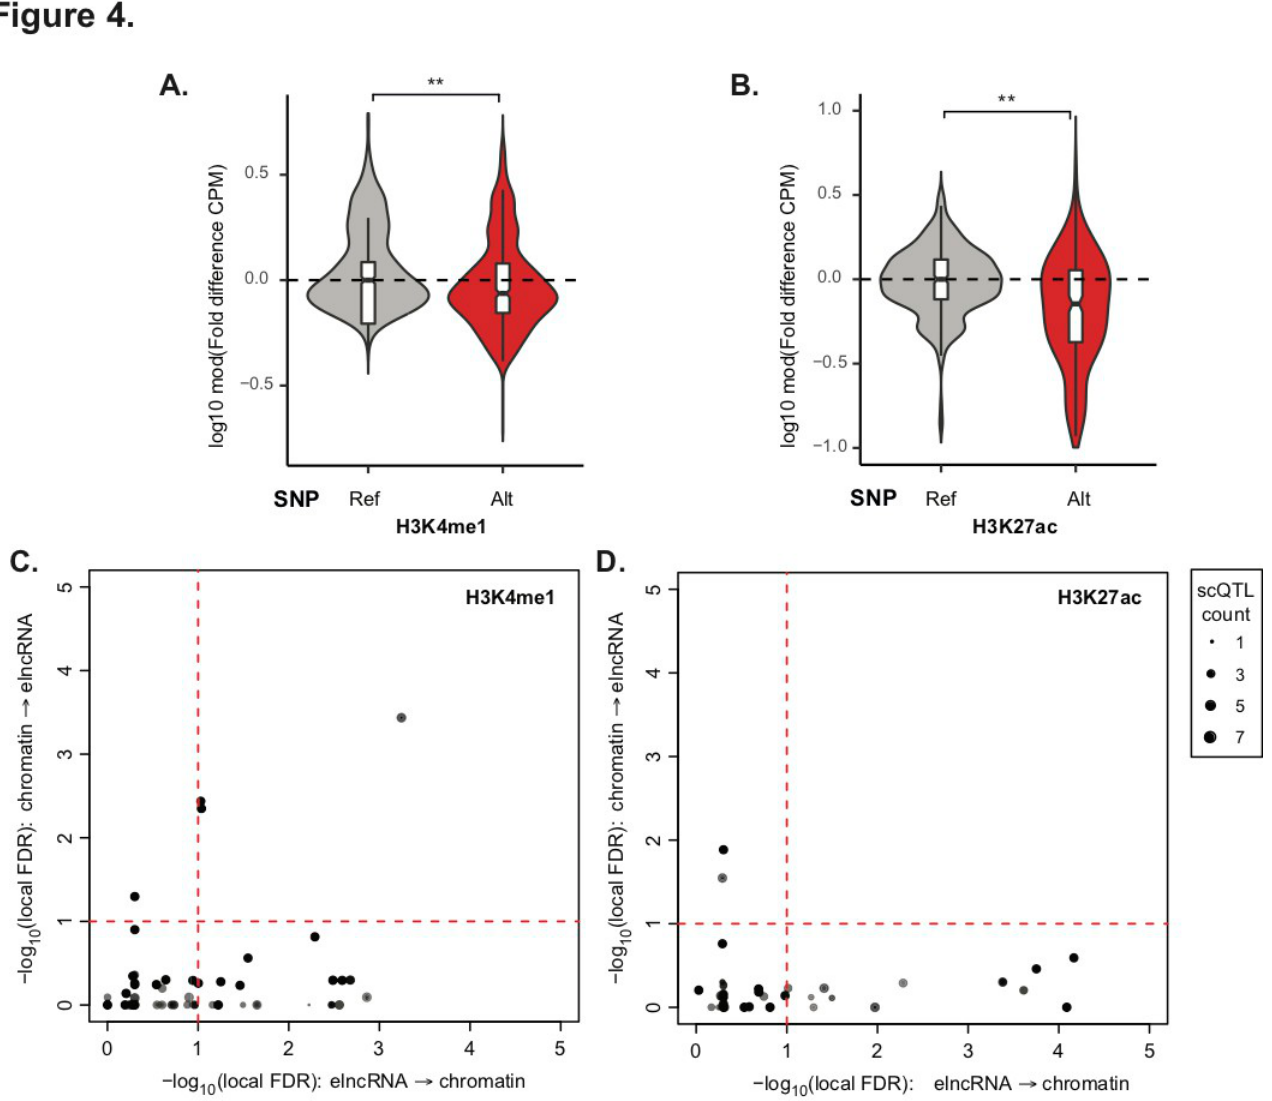
Fig 4. Impact of elncRNA splicing on cognate enhancer chromatin signatures in the human population. Distribution of the average log modulus fold difference in chromatin signature, relative to the median of samples with reference genotype, between individuals that carry alternative or reference alleles at elncRNA splice sites, in (A) H3K4me1 and (B) H3K27ac. (C-D) Scatterplot depicting joint elncRNA scQTLs in which elncRNA splicing is causally or non- casually predicted to mediate enhancer chromatin signatures, (C) H3K4me1 and (D) H3K27ac, respectively, using causal inference testing as illustrated using local FDR associated with the four models (as shown in Fig 4B). Dotted black lines denote significance threshold at local FDR < 0.1. Differences between groups were tested using a two-tailed Mann-Whitney U test. �� p < 0.01.